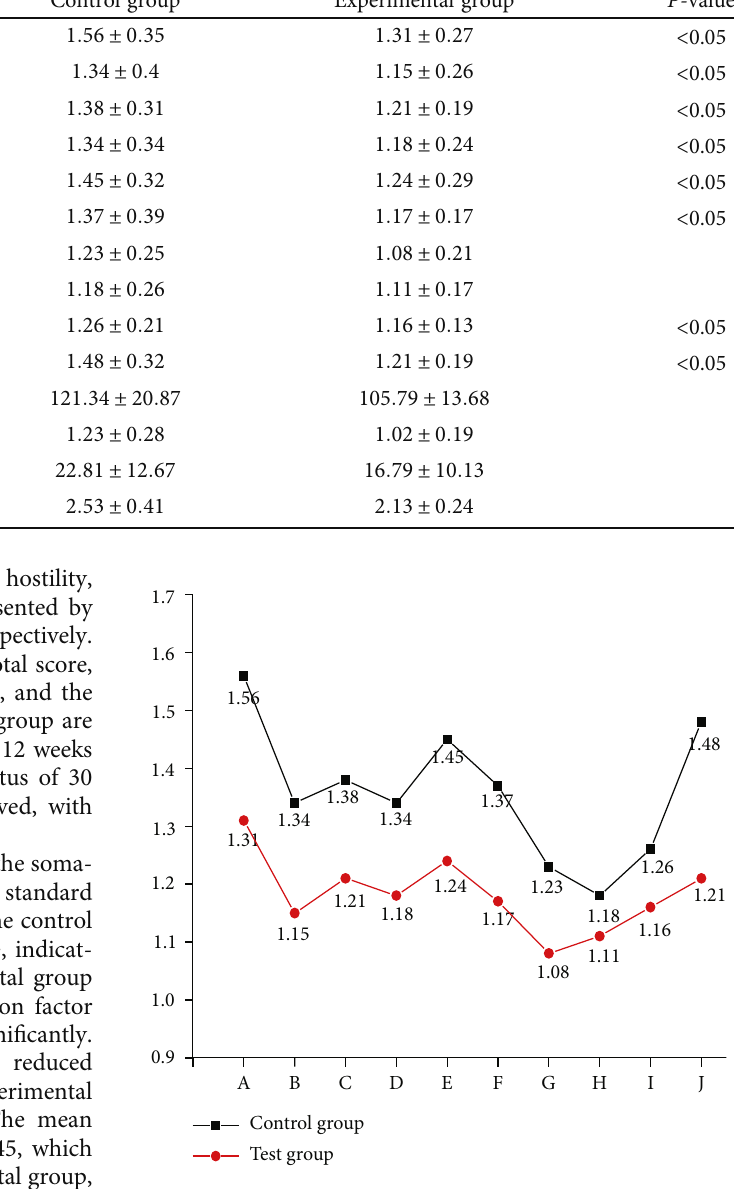
Figure 7: Comparison of improvement of mental health indexes after the